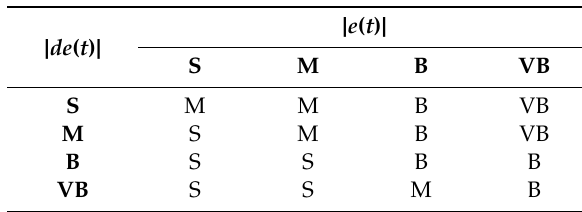
Figure 5. Setup membership functions of the inputs and output fuzzy logic system. Table 1. Fuzzy rule of K p .